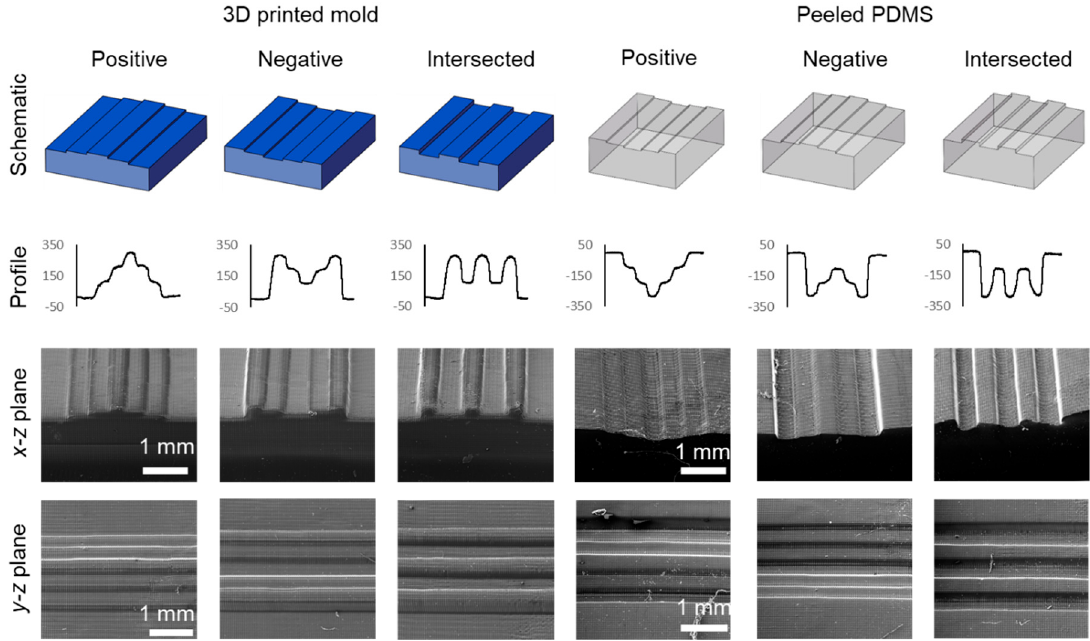
Figure 5. Surface profile data and SEM images of the 3D printed mold and corresponding polydimethylsiloxane (PDMS) patterns with multi-depth features.